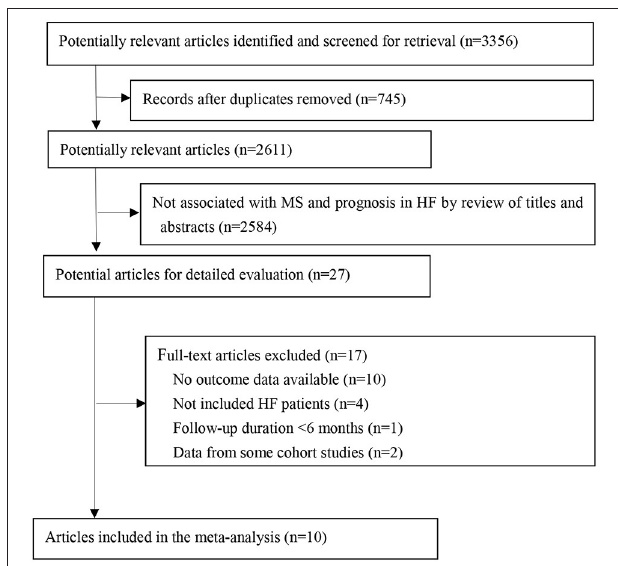
FIGURE 1 | Flow diagram of study selection. HF, heart failure; MS, metabolic syndrome.